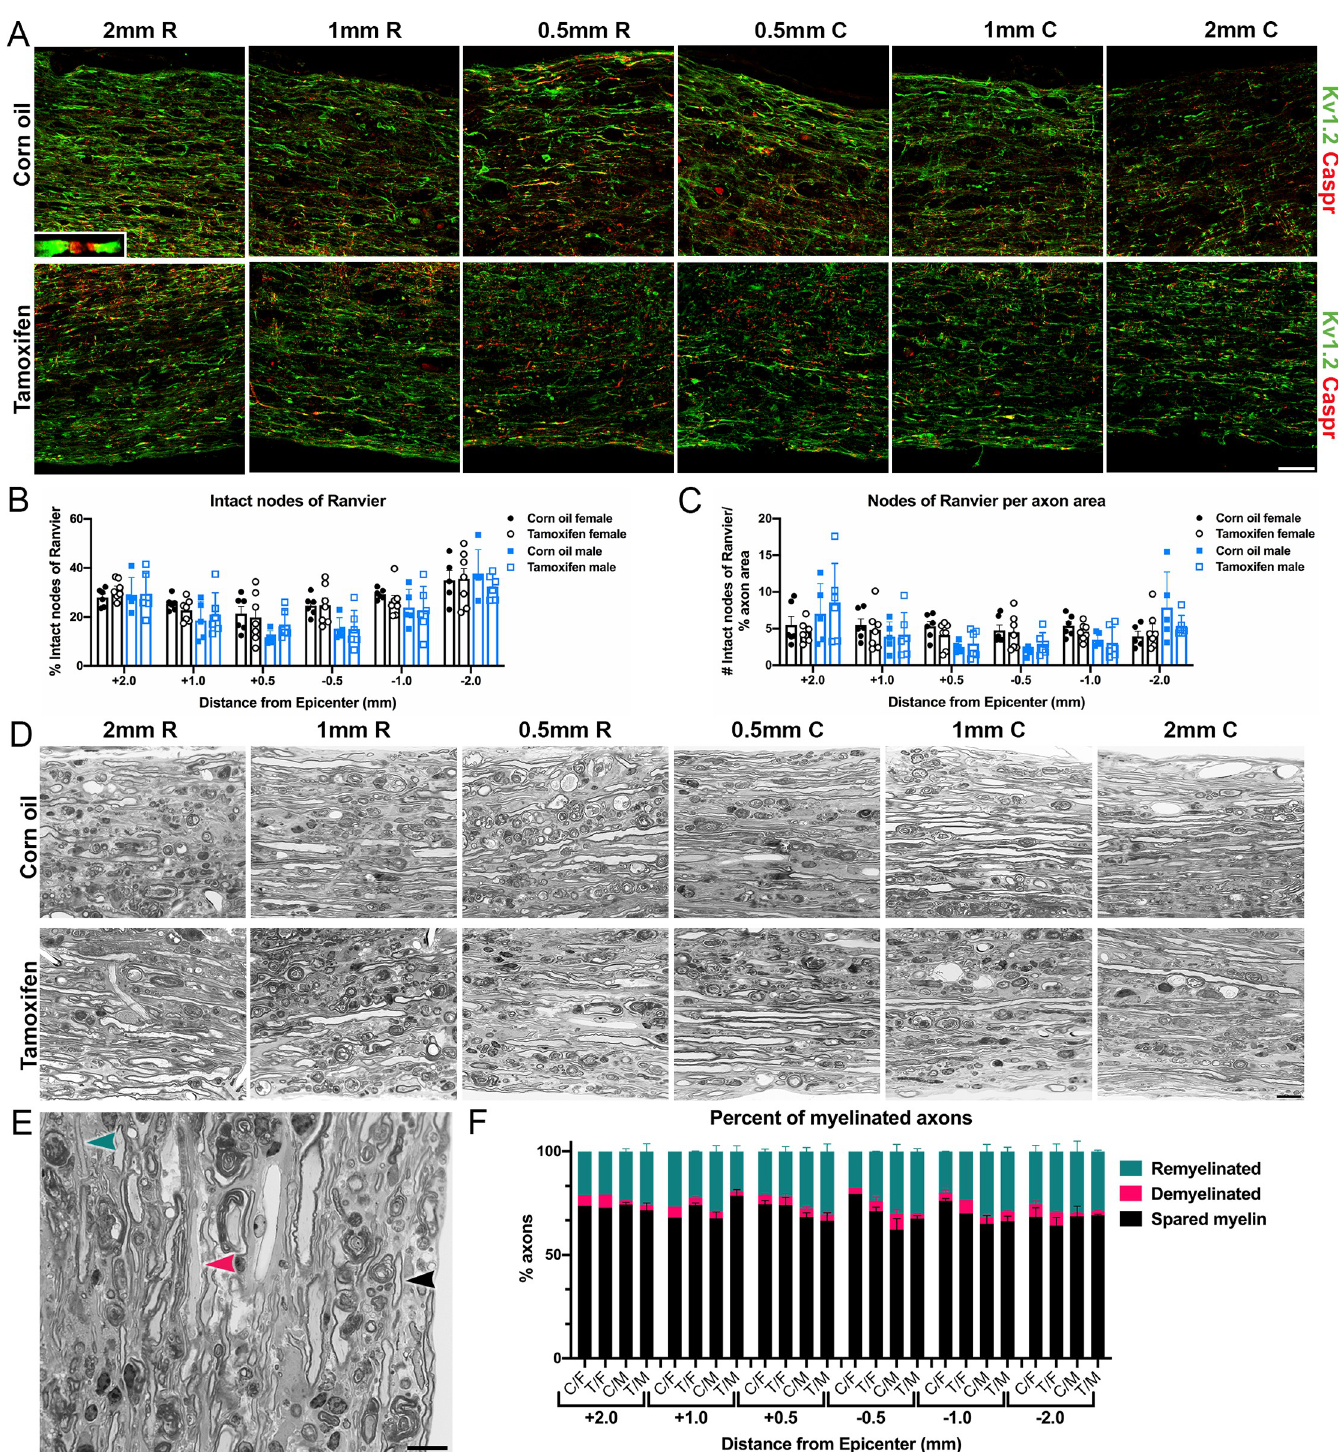
Fig 9. Demyelination and remyelination are unaffected by delayed short-term tamoxifen administration. (A) Representative confocal images of longitudinal spinal cords immunolabeled for Kv1.2 and Caspr at 2 mm, 1 mm, and 0.5 mm rostral and caudal to the lesion epicenter. Inset shows a higher-power view of a node of Ranvier. Scale bar = 75 μ m. (B) Percent of intact nodes of Ranvier in the lateral white matter at each sampled region. (C) Number of intact nodes of Ranvier normalized to percent axon area (Fig 4) in the lateral white matter at each sampled region. (D) Representative images of semi-thin longitudinal sections stained for toluidine blue from corn oil and tamoxifen mice at 2 mm, 1 mm, and 0.5 mm rostral and caudal to the lesion epicenter. Scale bar = 10 μ m. (E) High-power image with arrowheads showing